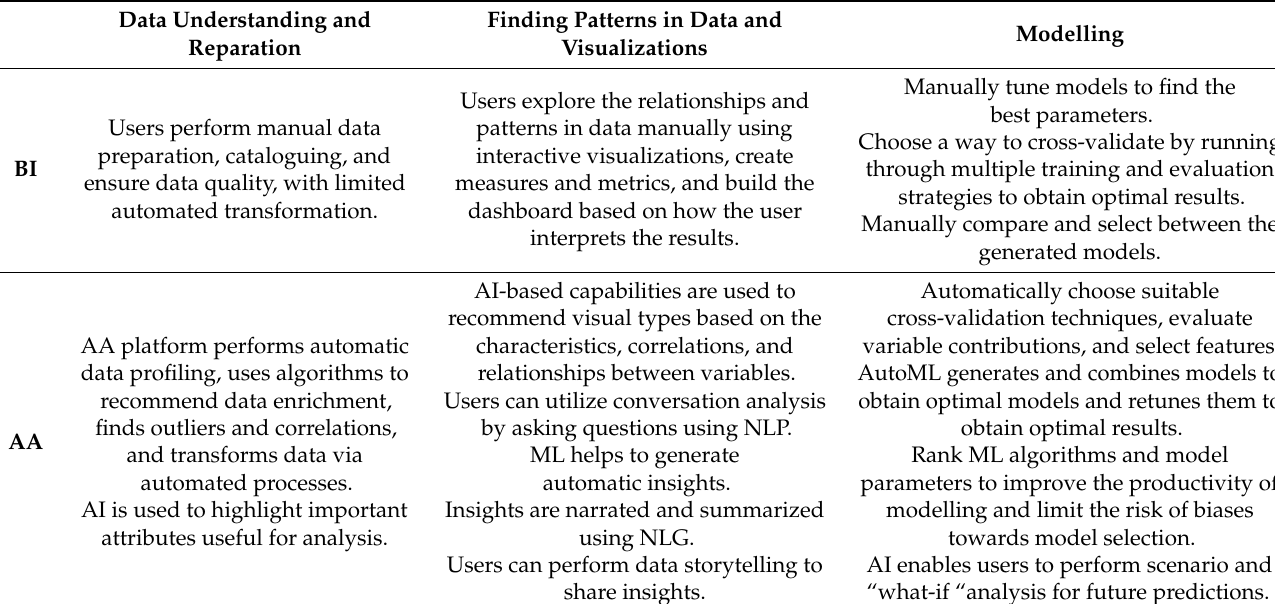
Table 4. Comparison between traditional BI and AA approaches in